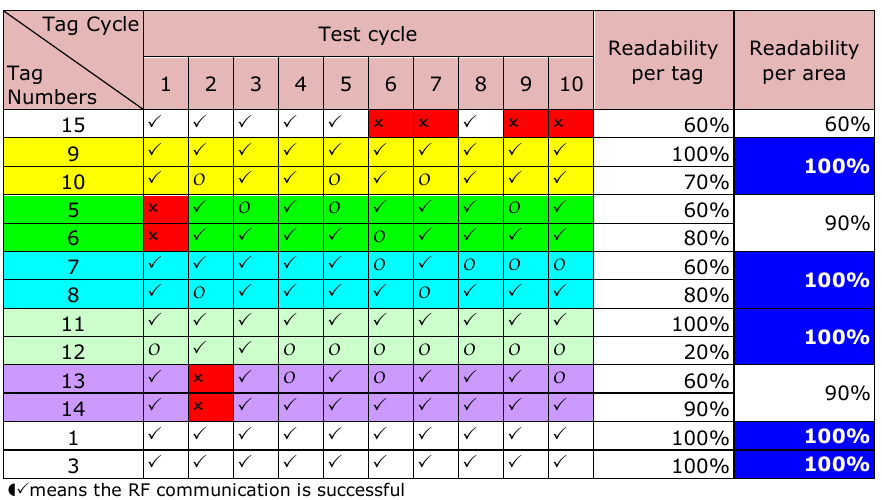
Table 4. Result of Second Stage test